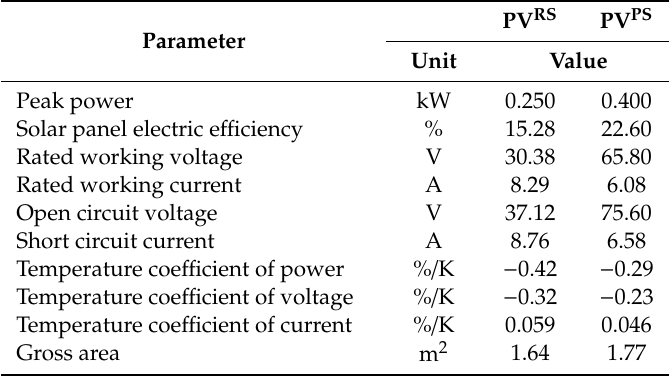
Table 2. PV RS and PV PS panels technical data.